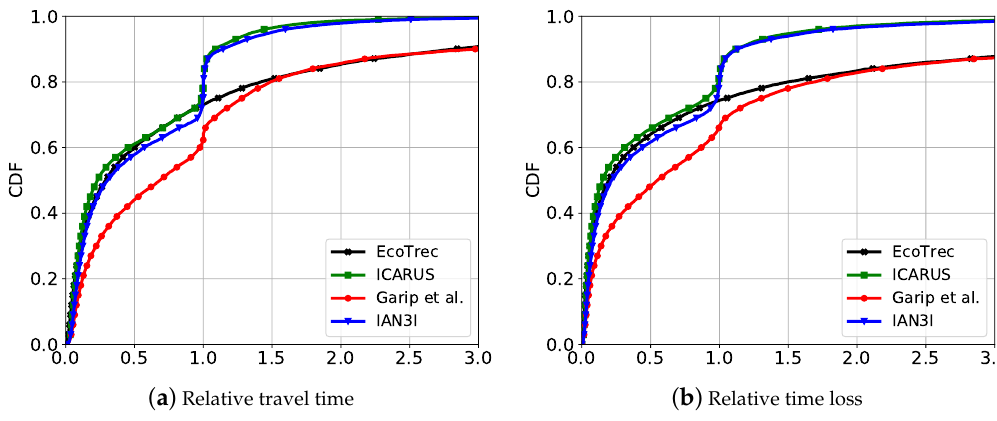
Figure 6. Traffic efficiency results using relative metrics for dealing with recurrent traffic